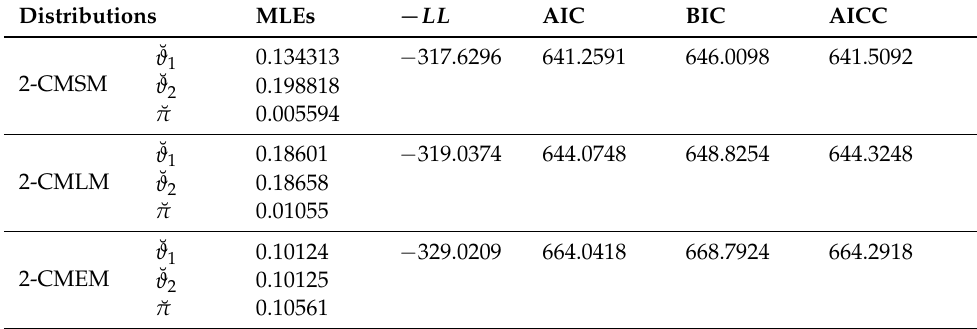
Table 1. MLEs, and GOF statistics for Dataset I.